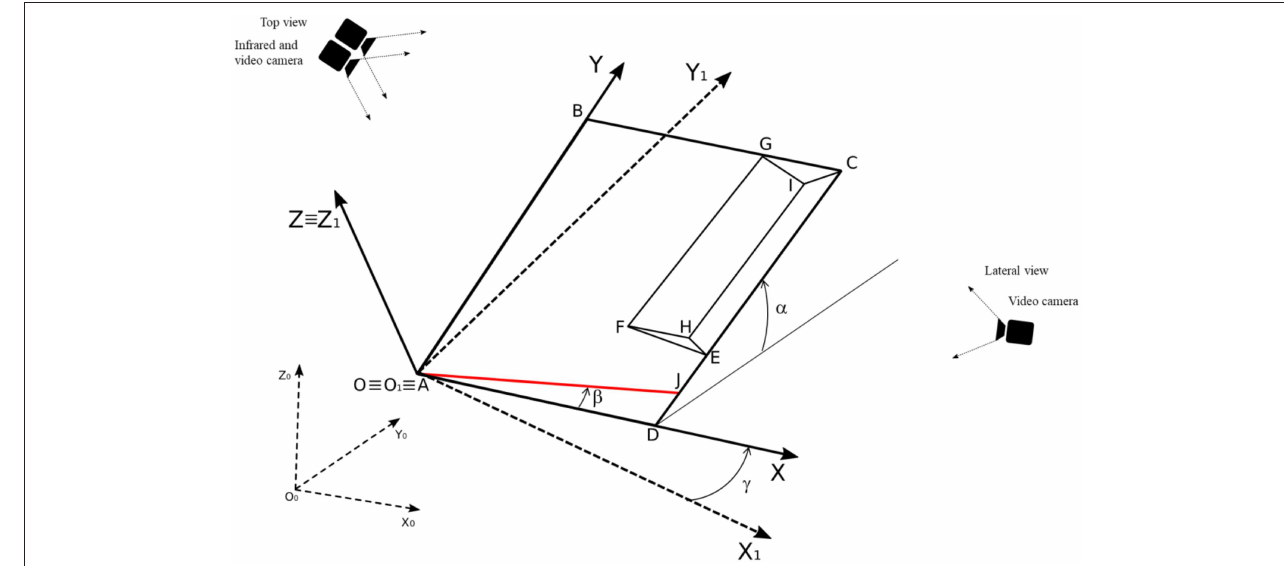
FIGURE 1 | The variation of test table geometry.